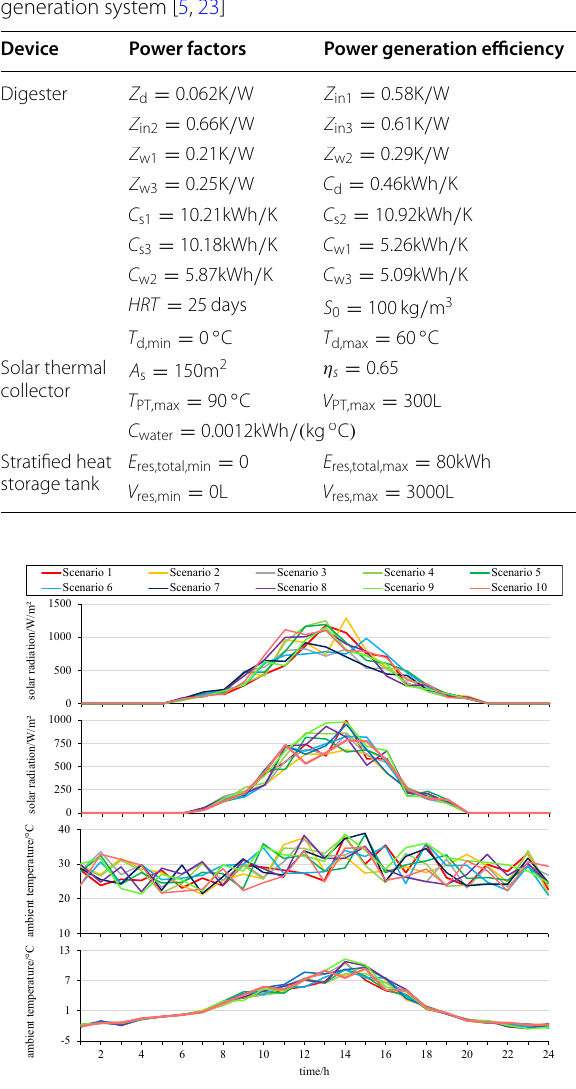
Fig. 7 The daily solar radiation and ambient temperature of 10